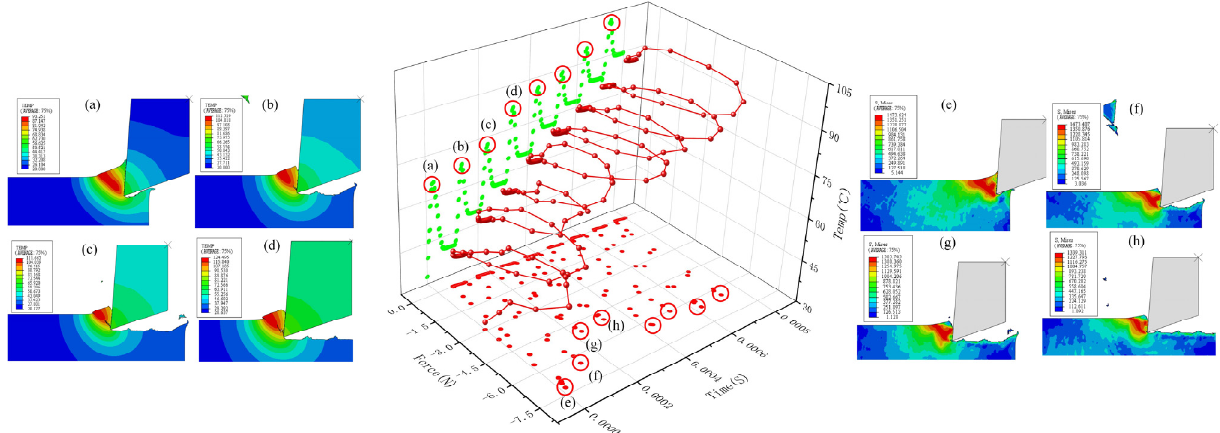
Figure 10. UEVC force–thermal evolution law (Temp-Cutting